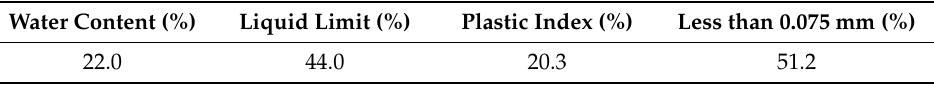
Table 1. Physical properties of granite residual soil in Guangdong.